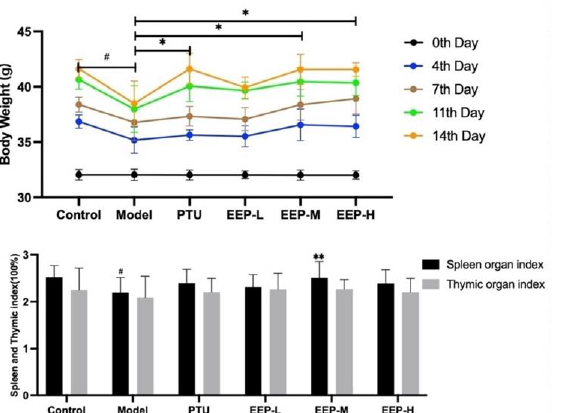
Figure 2. Effect of EEP treatment on changes in body weight, the thymus index, and the spleen index in hyperthyroidism mice. Data are presented as mean±SEM ( n = 8). # p < 0.05versus Control. * p < 0.05, ** p < 0.01 versus Model.